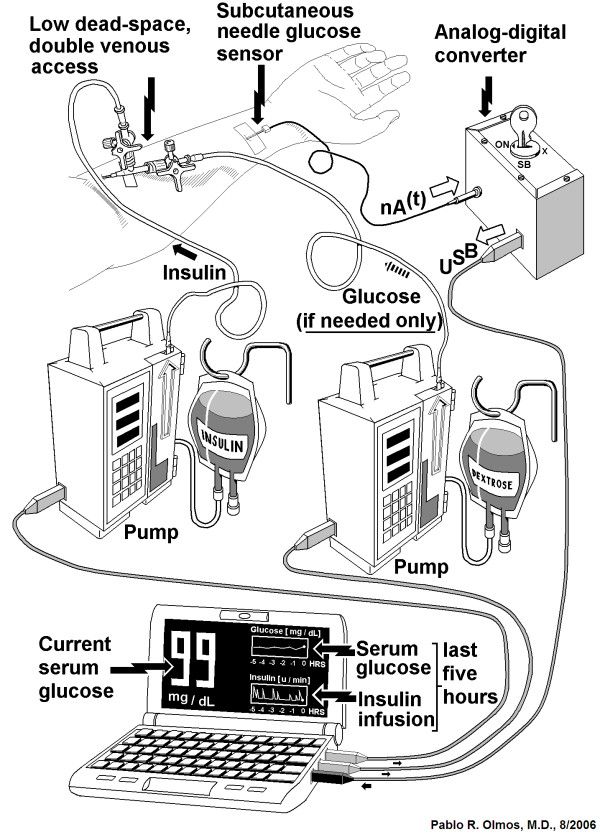
"Automatic Insulin Infusion System" (AIIS) for Inpatient Treatment: Proposed architecture. Proposed architecture of the "Automatic Insulin Infusion System" (AIIS) for Inpatient Treatment (see text). The nano amperimetric current produced by the subcutaneous glucose sensor located at the forearm of the patient, is shown entering an analog-digital converter. This device has two tasks. (a) To continuously measure the current from the sensor, and average it every five minutes, and (b) to transform the 5-minute average into a digital signal, that is submitted to the computer (where the controller is located) by means of an USB cable. From the computer, two USB cables are connected to infusion pumps, one for insulin, and the other for glucose solution. Note the low-dead-space catheter placed in a vein of the forearm of the patient. The low dead space allows for a rapid transition from insulin to glucose infusion and vice-versa.